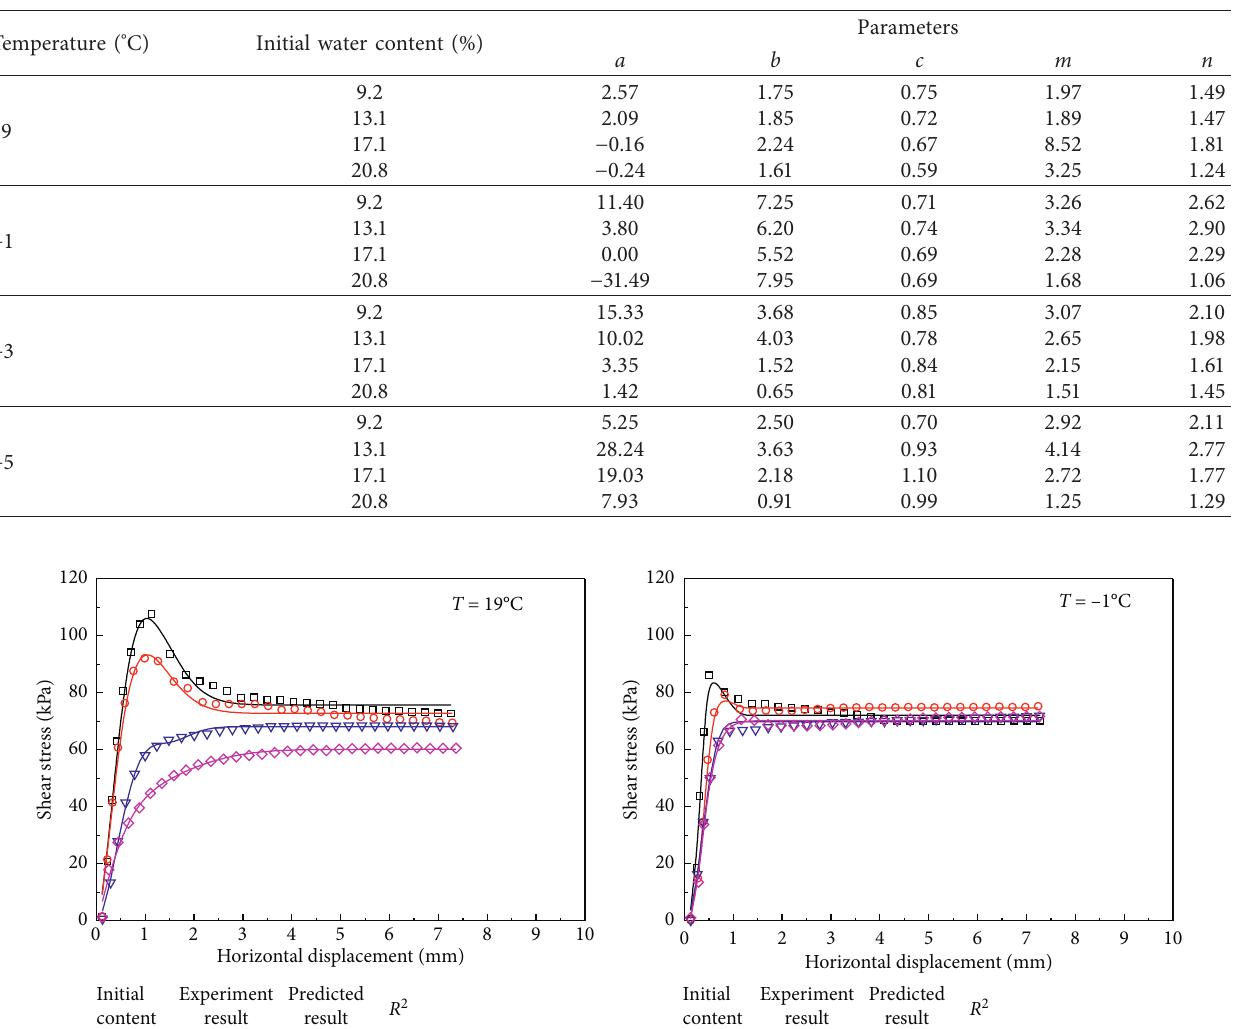
Figure 7: ln τ ∗ versus ln δ Table 3: Model parameters.